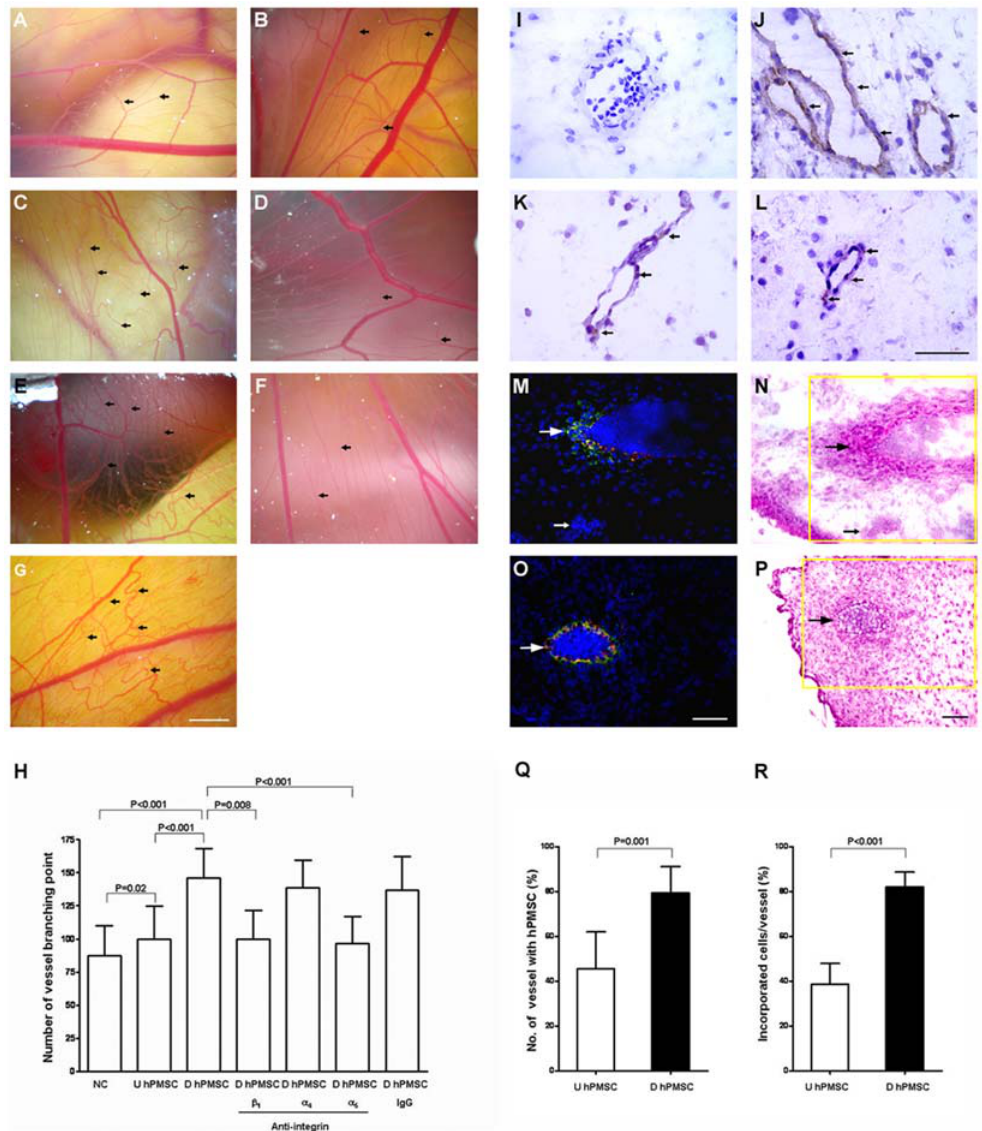
Figure 6. Stimulation of angiogenesis in chick chorioallantoic membrane (CAM) by undifferentiated or differentiated human placental multipotent mesenchymal stromal cells (hPMSCs). Small tortuous blood vessels, typical of neovascularization, were visible in the CAM. The development of new blood vessels was determined by counting branch points (arrows) after 48 hours of cell transplantation. Sprouting and branching vessels (arrows) are prominent in the CAM transplanted by (C) differentiated hPMSCs compared to the (A) negative control (fresh culture medium) without hPMSC transplantation and (B) undifferentiated hPMSCs transplantation. CAMs were implanted by differentiated hPMSCs pre-treated with antibodies against integrin (D) b 1 , (E) a 4 , (F) a 5 , or (G) non-specific IgG. Scale bar: 3 mm. Representative photomicrographs of 6 different chicken embryos are shown. (H) Quantification of new blood vessels formed by negative control (NC; fresh culture medium) or hPMSCs in CAM. The angiogenic effect was substantially reduced in hPMSCs pre-treated with anti-integrin a 5 or b 1 antibody. Cryosections of CAMs were immunostained by (I) von Willebrand factor (vWF), (J) vWF, (K) CD31, and (L) CD105 antibodies. (I) CAM without hPMSC transplantation was negative for vWF staining, indicating human vWF antibody does not cross react with CAM. (J–L) Arrows indicated vWF, CD31 and CD105-positive cells present in CAM, revealing that differentiated hPMSCs contributed to neovascularization. CAM transplanted with (M) undifferentiated hPMSCs or (O) differentiated hPMSCs were immunostained using a rhodamine (red)-conjugated human vWF antibody. The hPMCs were labeled with CellTracker TM CMFDA (green). DAPI (blue) staining was used to identify nuclei. The incorporation of hPMSC into CAM endothelium that expressed vWF would reveal yellow signal. Differentiated hPMSCs were widely incorporated into endothelium of CAM vessels (O). A large arrow indicates the hPMSCs incorporated into CAM vessel endothelium. A small arrow indicates a nearby vessel lacking both engrafted hPMSCs and human vWF expression (M). Plenty of nucleated red blood cells were observed within the lumens of vessels. (N, P) Hematoxylin-eosin stained serial sections with inset areas matching images of M and O. Scale bar: 50 m m. (Q) Quantification of the number of new vessels formation that contained hPMSCs after transplantation of differentiated or undifferentiated hPMSCs. (R) Quantification of the number of hPMSCs incorporated into vessel endothelium after transplantation of differentiated or undifferentiated hPMSCs. D hPMSCs: differentiated hPMSCs; U hPMSCs: undifferentiated hPMSCs; Error bar: SD.